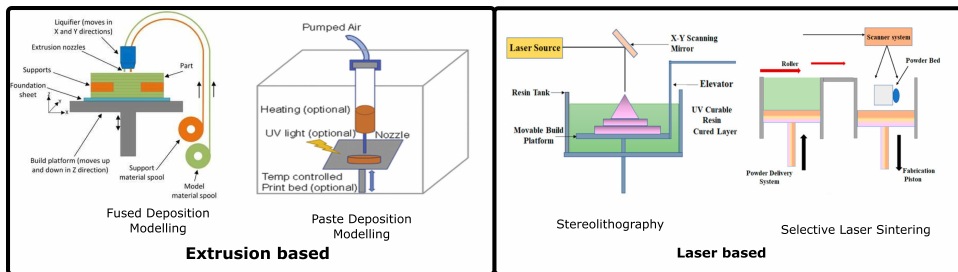
Figure 3. Additive manufacturing technologies used for the 3D printing of polymer-bioactive glass scaffolds. (Reproduced with permission from [61,62] under creative commons CC-BY license) (Reproduced with permission from [63] Copyright 2020,